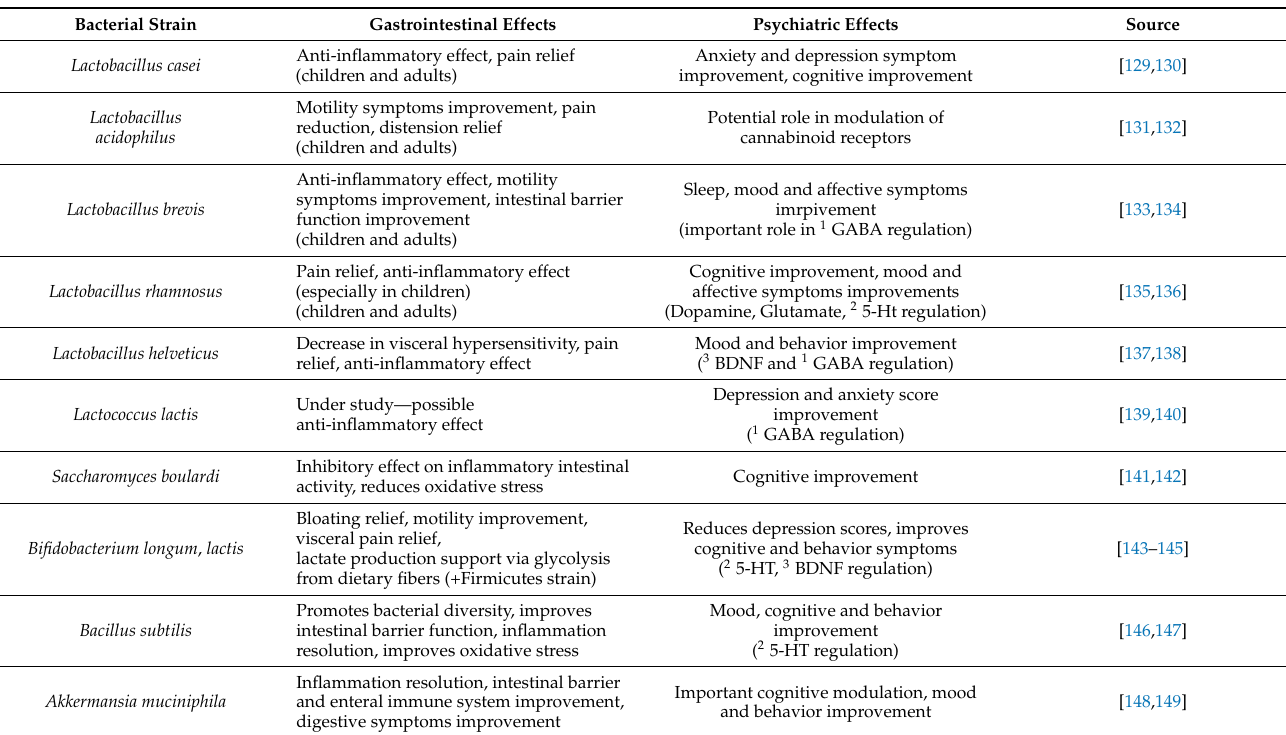
Table 1. Bacterial strains with potential “psychobiotic” usage in functional digestive